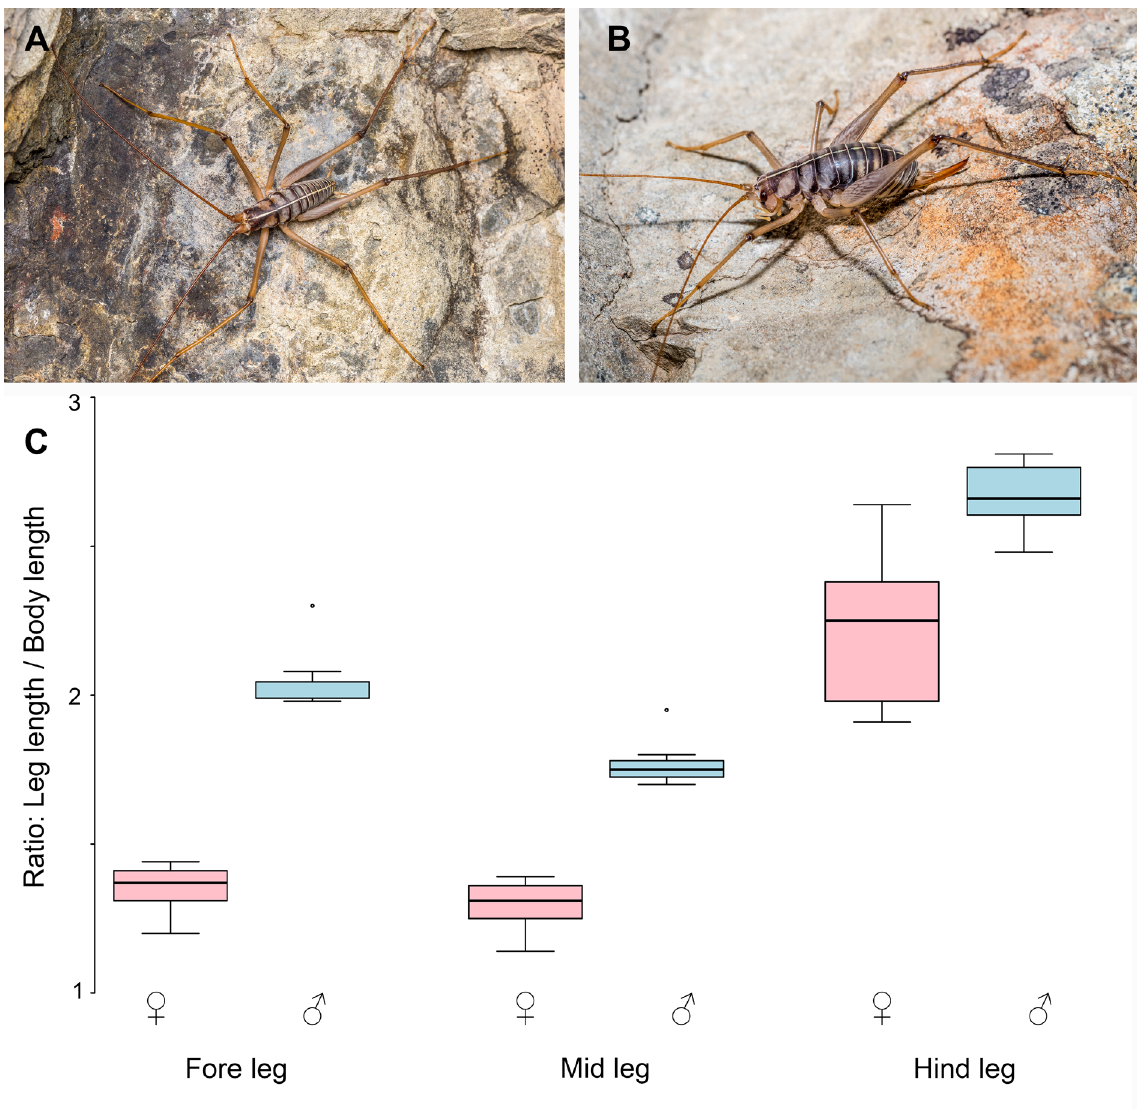
Fig. 17. Sexual dimorphism in the legs of Pleioplectron rodmorrisi sp. nov., with boxplot for a sample of 8 adult males and 7 adult females. ‘Leg length’ was calculated as the sum of the lengths of femur and tibia. A–B . Photographs of live specimens of P. rodmorrisi sp. nov. in their natural environment. Kahutara Saddle, Seaward Kaikoura Range. A . Adult ♂. B . Adult ♀. C . Box plot for the ratio of leg length/body length, by sex. A one-way ANOVA test on leg length by sex shows that all legs are significantly longer in males than they are in females, with the following results: Fore leg: F = 198.5 on 1 and 13 degrees of freedom; P = 3 × 10 -9 ; R 2 = 0.9385. Mid leg: F = 130.9 on 1 and 13 degrees of freedom; P = 4 × 10 -8 ; R 2 = 0.9097. Hind leg: F = 16.18 on 1 and 13 degrees of freedom; P = 0.001; R 2 =